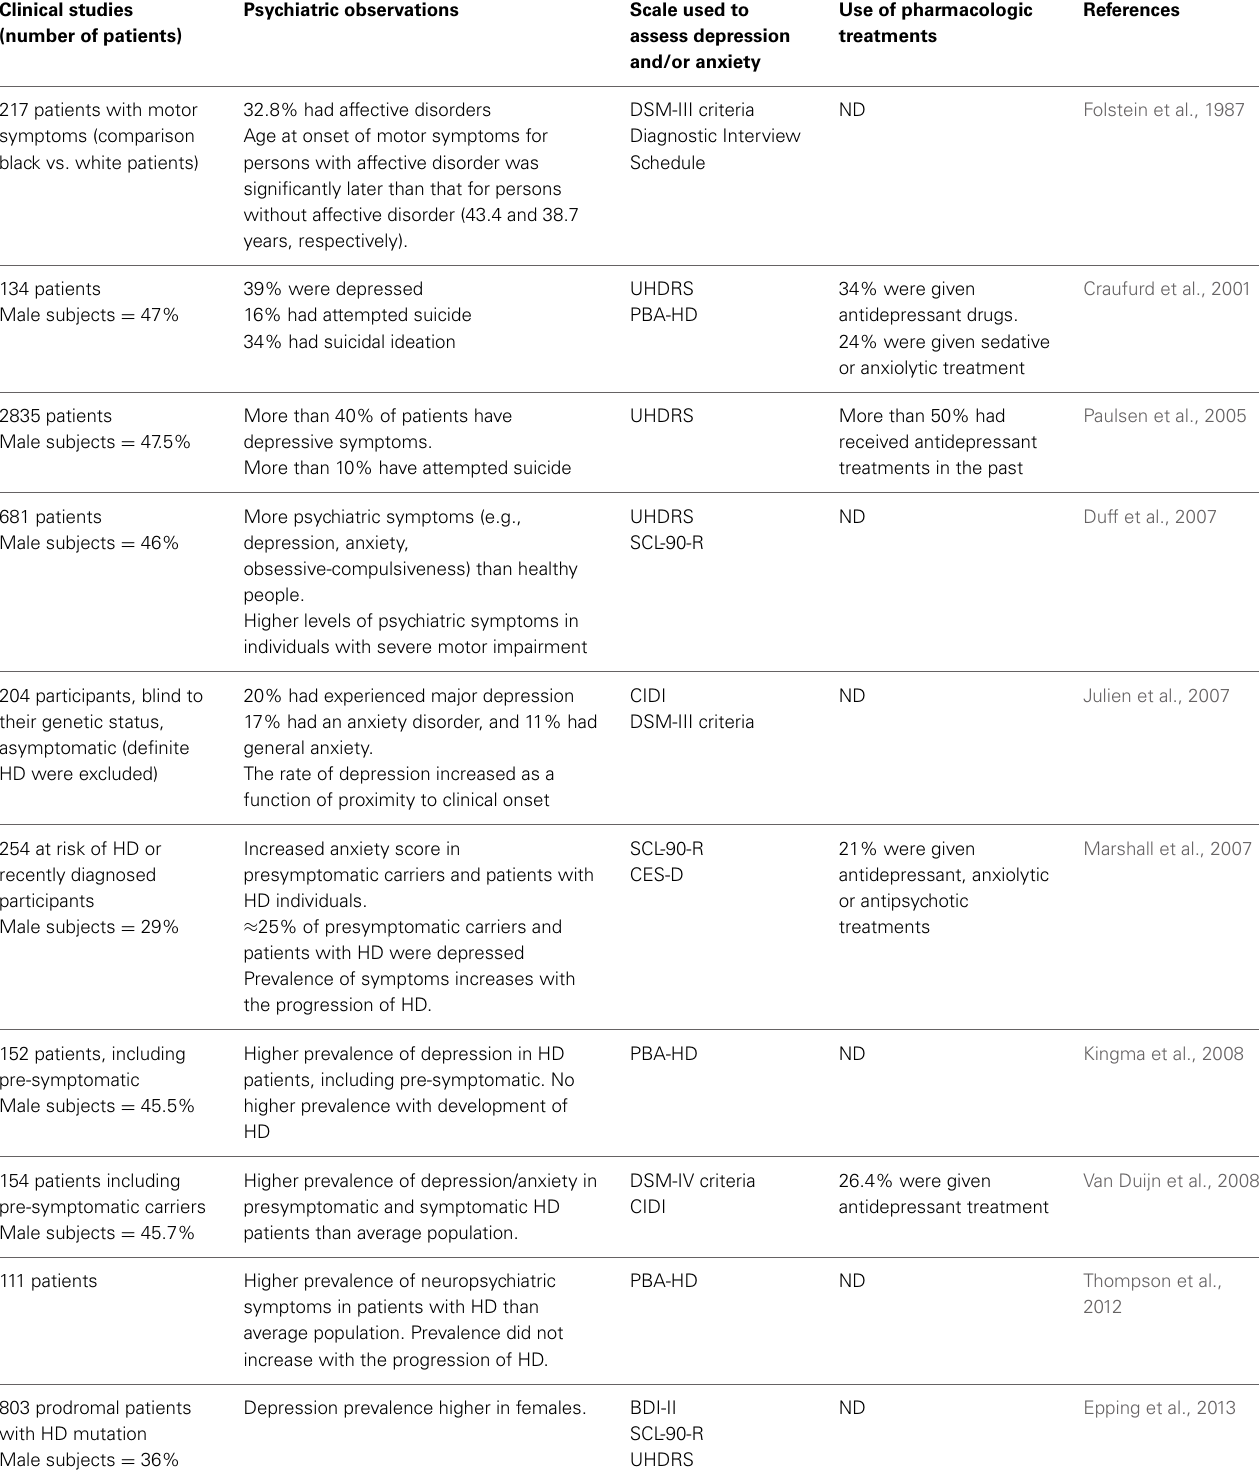
Table 1 | Clinical observations on Huntington’s disease